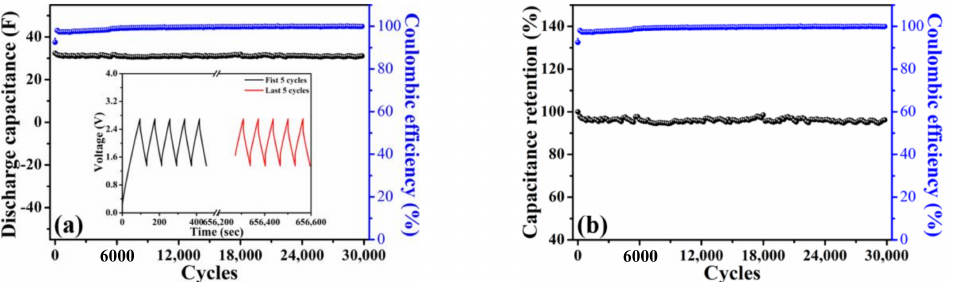
Figure 6. ( a ) Discharge capacitance as a function of cycle number and ( b ) capacitance retention of a pouch-type symmetric cell integrating by 10 pieces of high-mass loading hierarchically porous activated carbon electrodes in 1.35–2.7 V. The current used in is 1 A. Inset of ( a ) illustrates